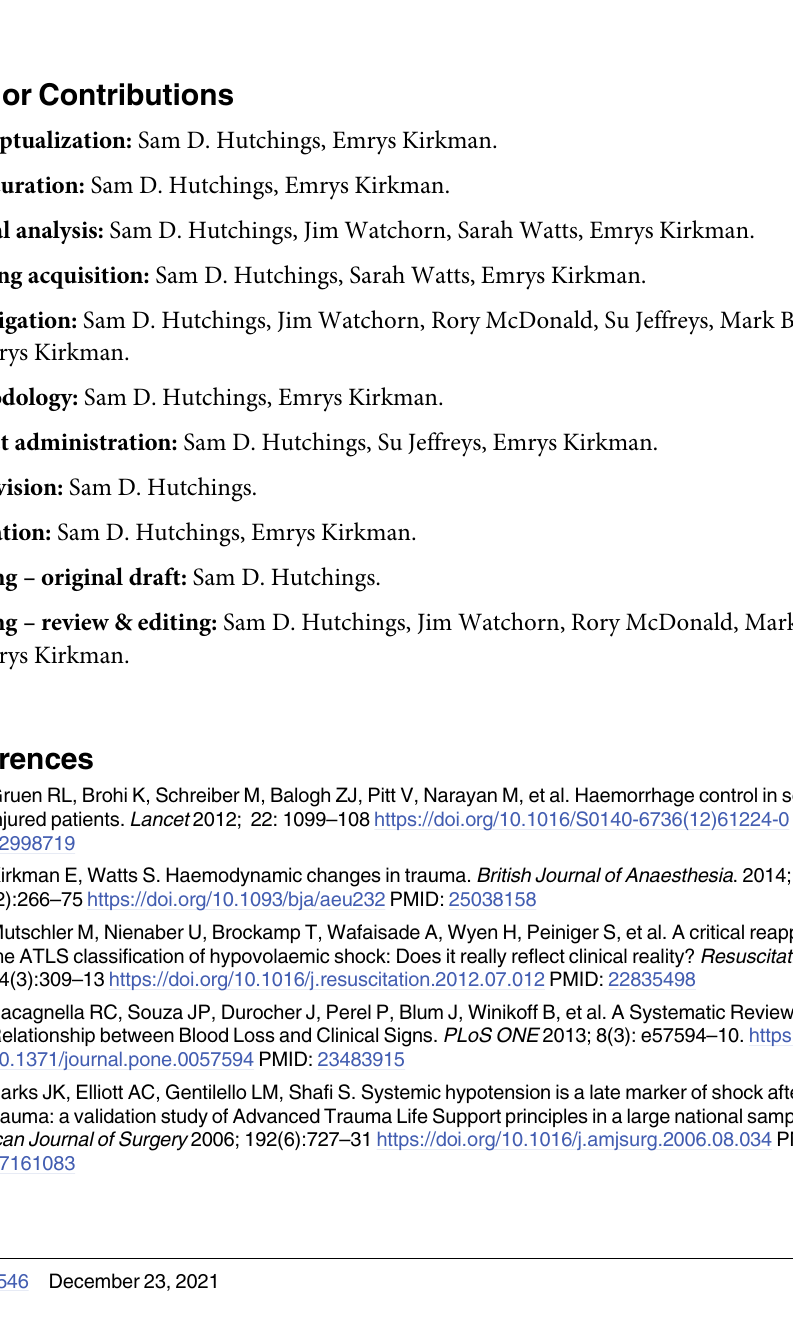
S1 Fig. Error grid polygons. Smoothed polygon created from the Excel spreadsheet presented in File S3. Colours indicate degree of harm Red (Severe), Orange (Moderate), Yellow (Mild), Green